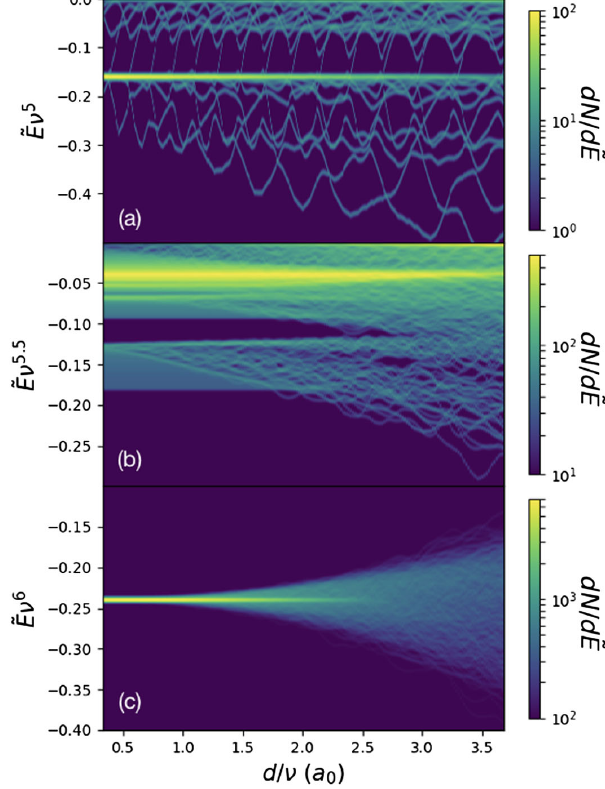
˜ E for a ν ¼ 30 composite in 1D